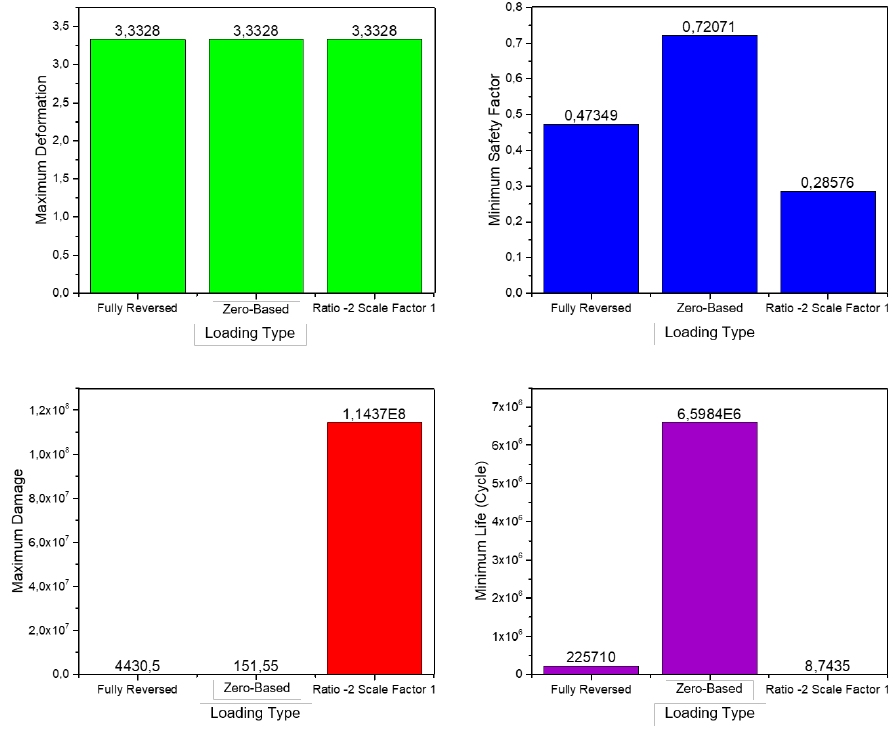
Figure 23. Fatigue Results: Maximum Deformation, Minimum Safety Factor, Maximum Damage, and Minimum Figure 23: Fatigue results: Maximum deformation, minimum safety factor, maximum damage, and minimum life for each loading Life for Each Loading Type